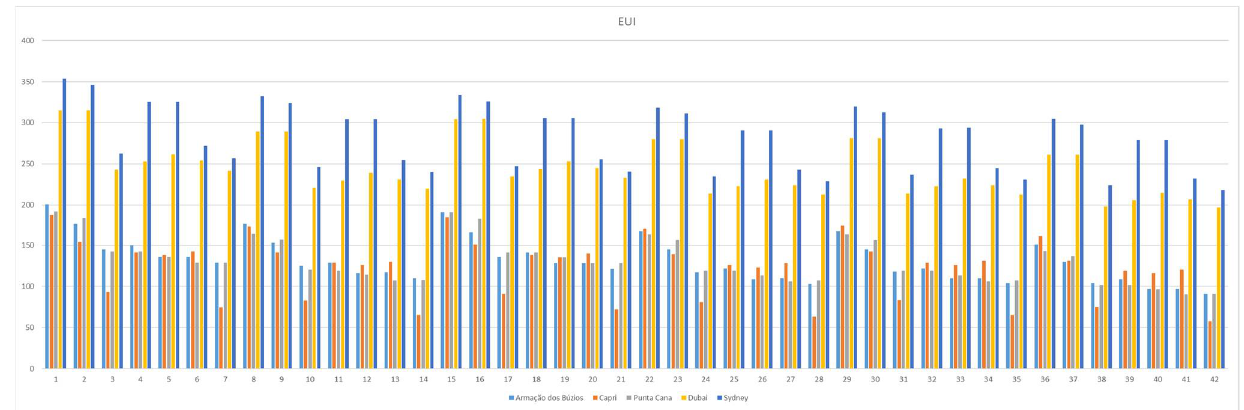
Figure 6. Graphic showing the results from the EUI